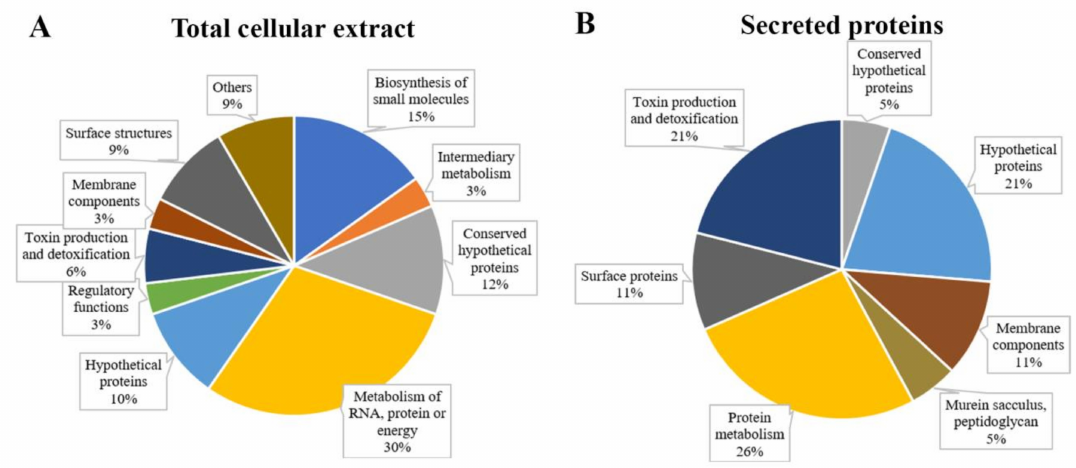
Figure 3. Functional distribution of identified X. fastidiosa proteins. Total cellular extract proteins ( A ) and secreted proteins ( B ) were grouped according to their biological processes and are expressed in percentage of the total proteins